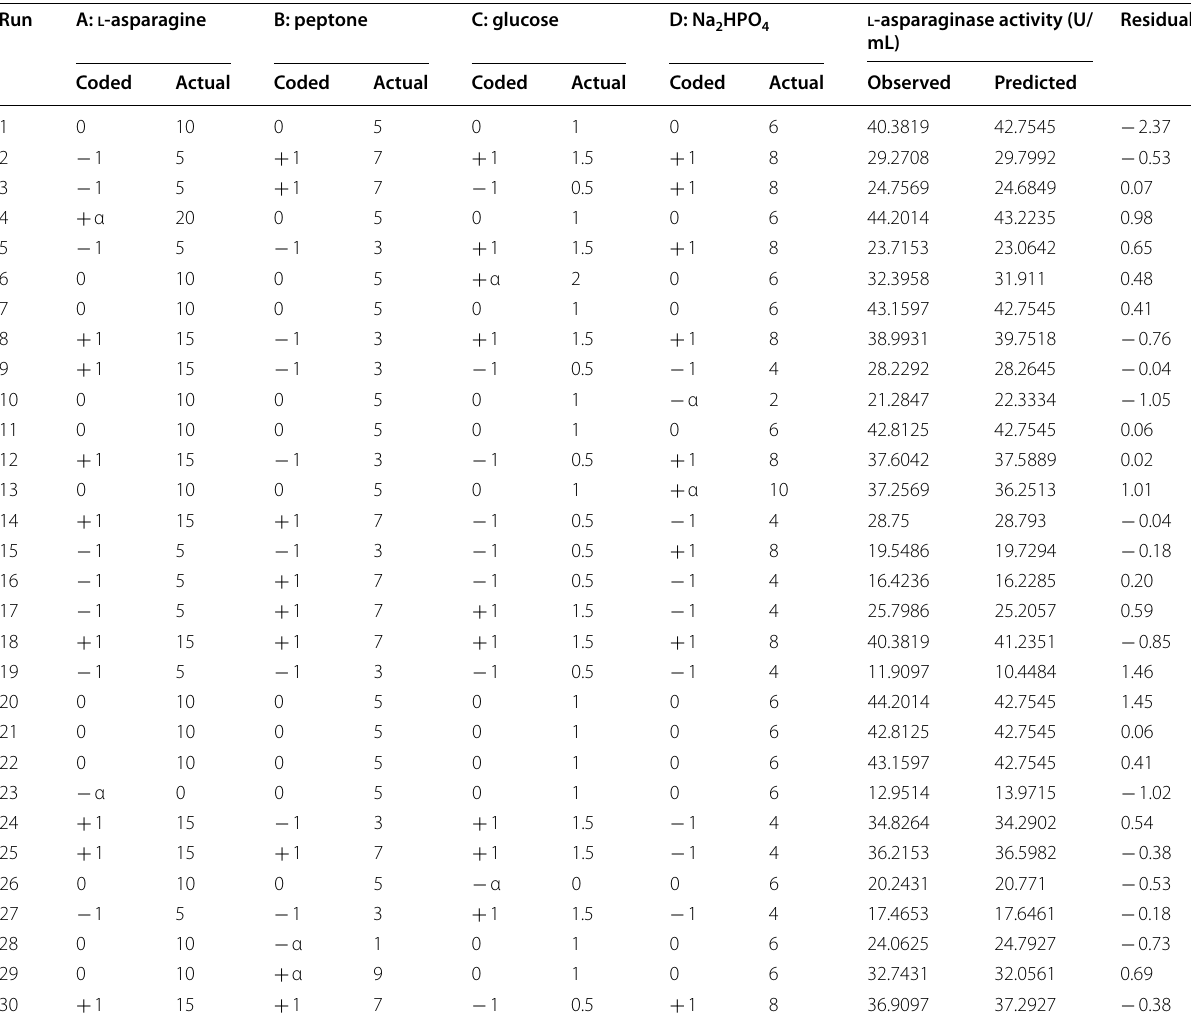
Table 4 CCD of selected variables with the experimental and predicted response